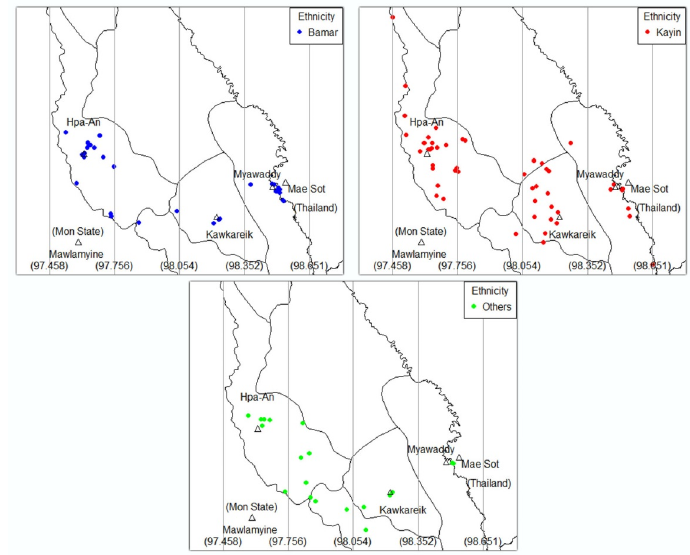
Figure 2 . Geographic distribution of Mycobacterium tuberculosis patients by ethnicity.